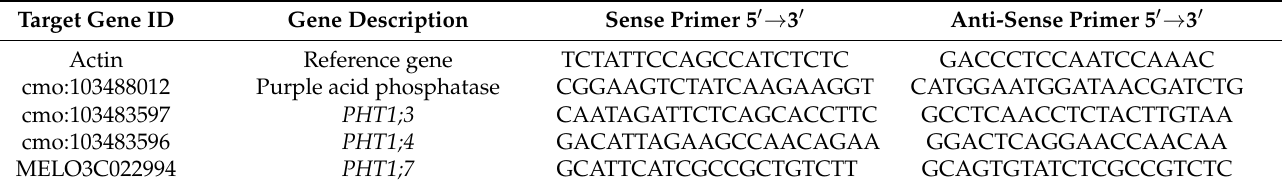
Table 1. Sequences of the primers used for